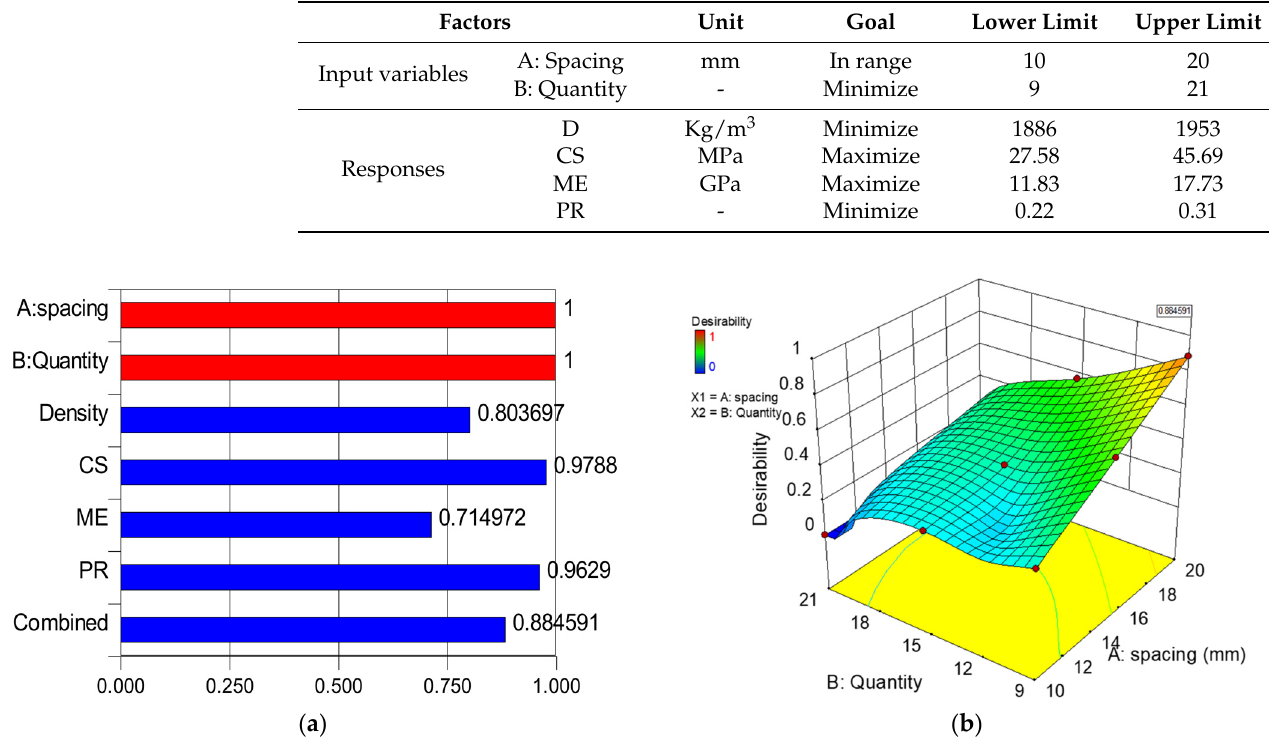
Figure 20. ( a ) Desirability value of individual factors; ( b ) Three-dimensional response surface diagram of the combined desirability of the optimization.